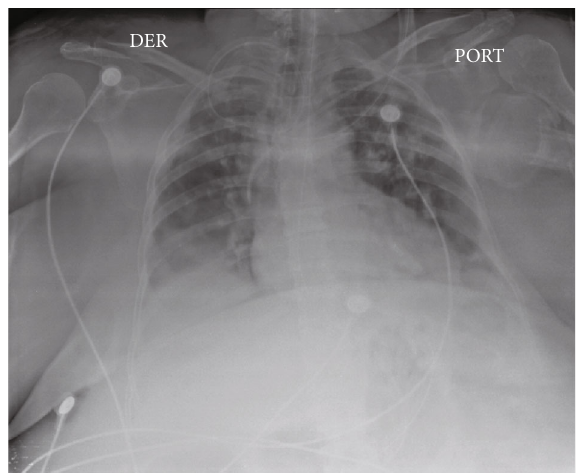
Figure 1: Portable chest X-ray ray revealing bilateral interstitial and alveolar in fi ltrates with right lung basal consolidation.